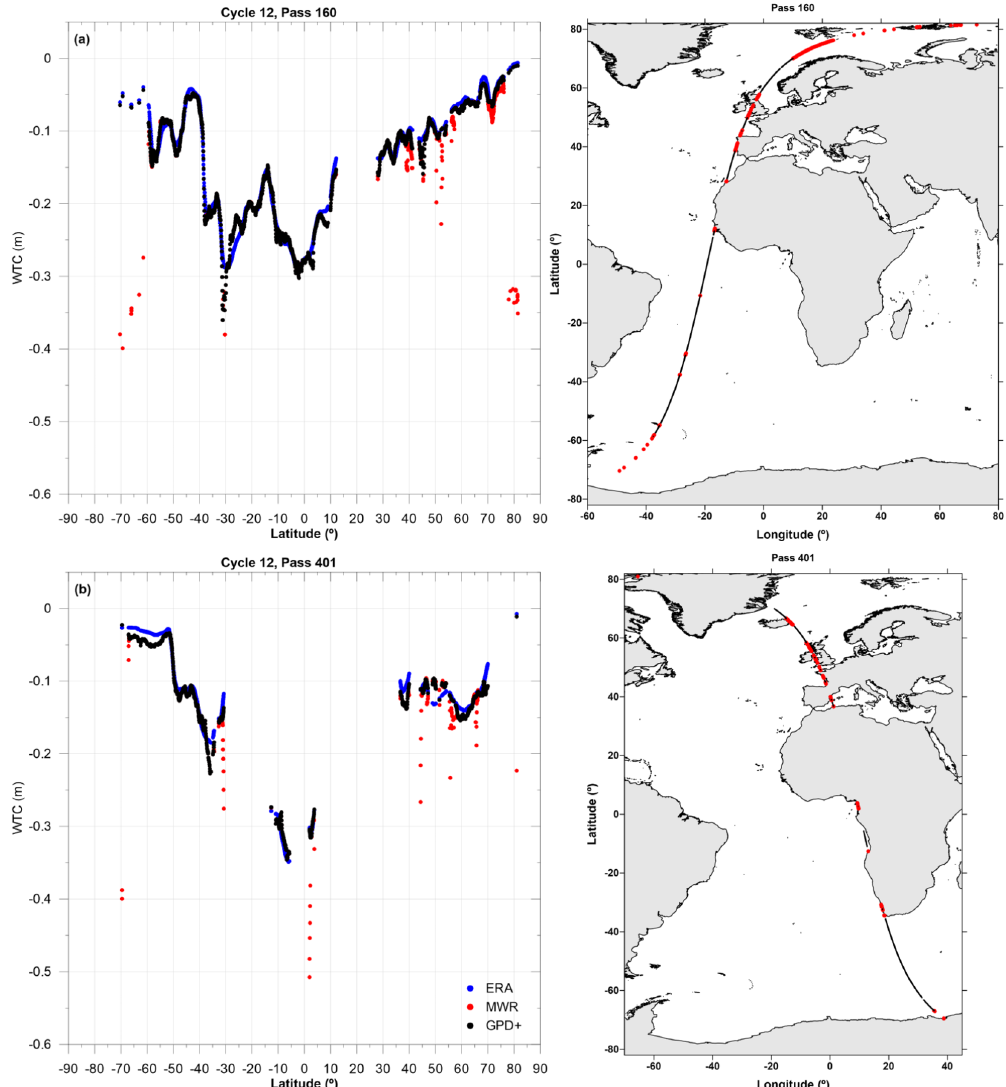
Figure 8. Same as Fig. 7 for Envisat tracks 160 and 401 (cycle 12) showing (a) the existence of outliers (red points located over ocean between latitudes 30 and 40 ◦ S) and (b) contamination by land